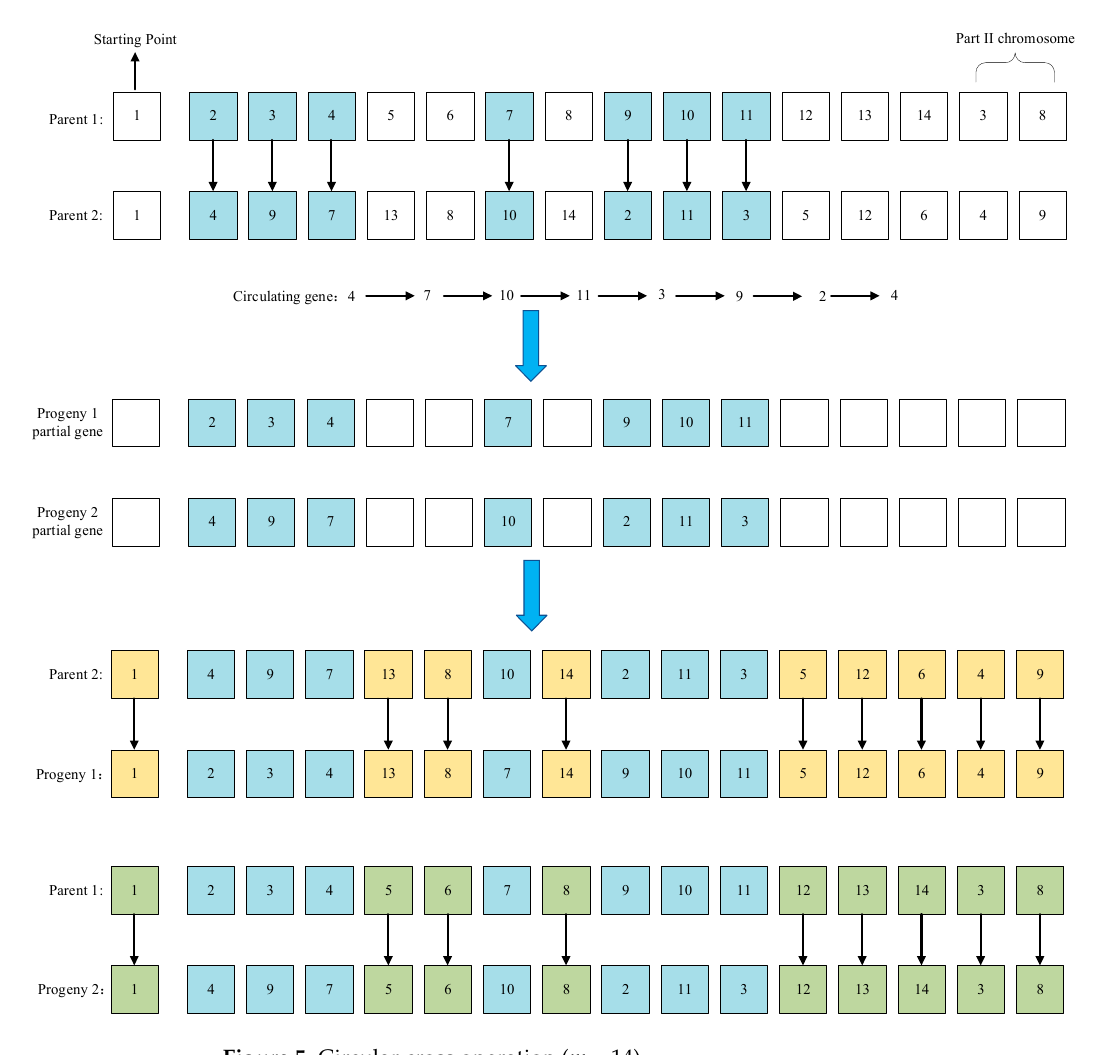
Figure 5. Circular cross operation ( m = 14). (3) Mutation operation According to the mutation probability Pm, the mutation operation of the number and sequence of tasks is realized by using the inversion, exchange, and insertion mutations. The inversion mutation reverses the continuous gene segments (task point execution sequence) of a segment, as shown in Figure 6. The exchange mutation randomly selects two genes in a chromosome to exchange positions, as shown in Figure 7. The insertion mutation randomly selects a gene or part of a gene in a chromosome to insert into a random site, as shown in Figure 8.